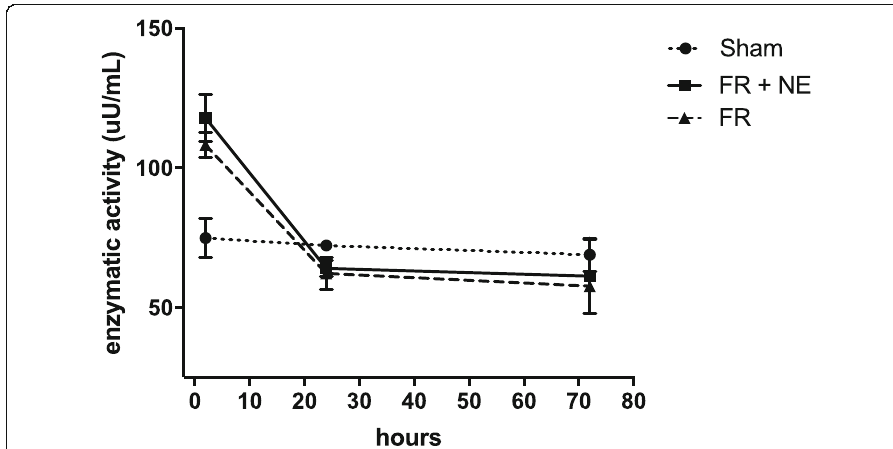
Fig. 2 Plasmatic xanthine oxidase. Xanthine oxidase concentration assessed by ELISA after 2, 24 and 72 h of reperfusion and expressed in uU/ml. N = 4 – 5/group at each time point, and asterisk indicates a significant difference between HS vs sham group, ( p <